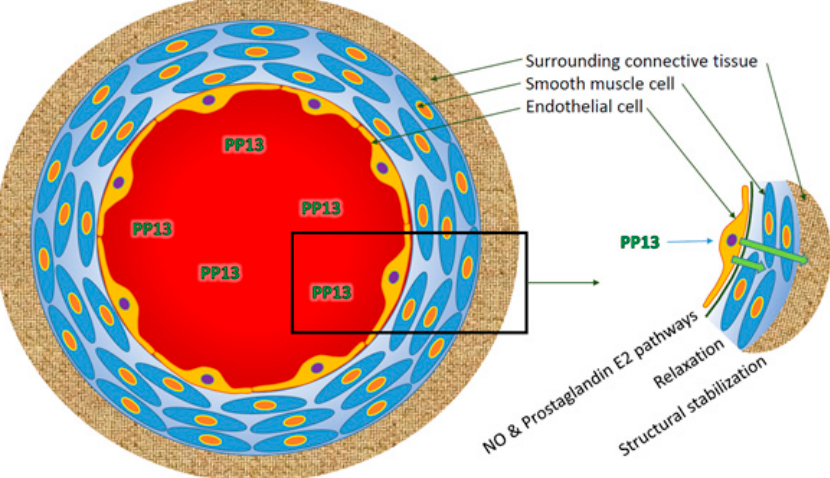
Figure 4. The e ff ect of PP13 on the various layers of blood vessels. PP13 acts on the endothelial layer of the blood vessels and causes vasodilation by muscle relaxation through the signaling pathways of eNOS and prostaglandin 2. Further, PP13 causes stabilization of the surrounding connective tissues. Molecularly, this process requires the carbohydrate recognition domain to cross link between PP13 and molecules on the surface of the connective tissue and extracellular